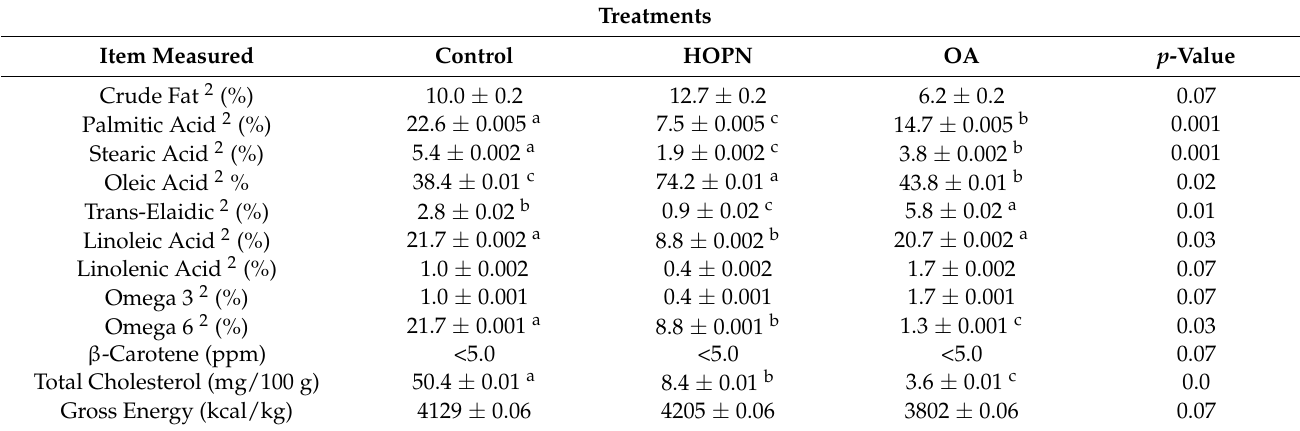
Table 2. Lipid content and fatty acid analysis of dietary treatments 1 .